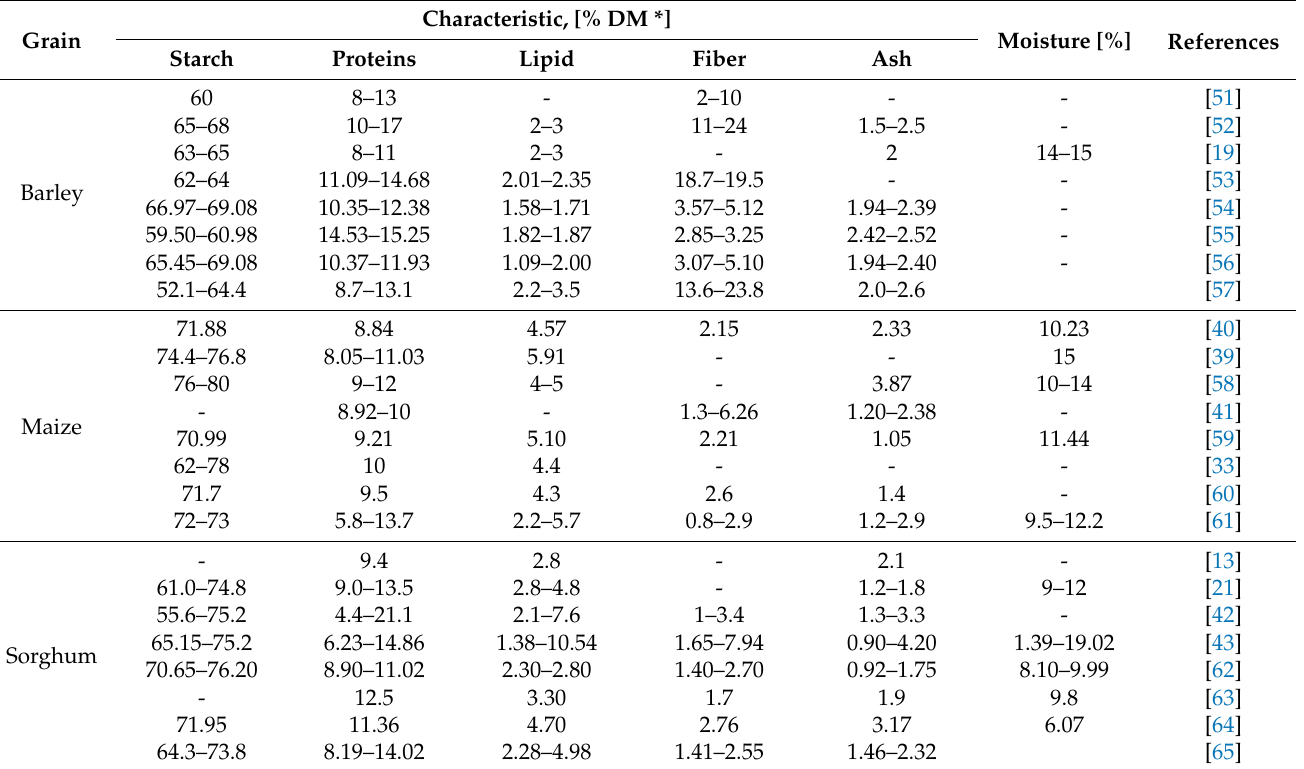
Table 1. Physicochemical characteristics of maize, sorghum and